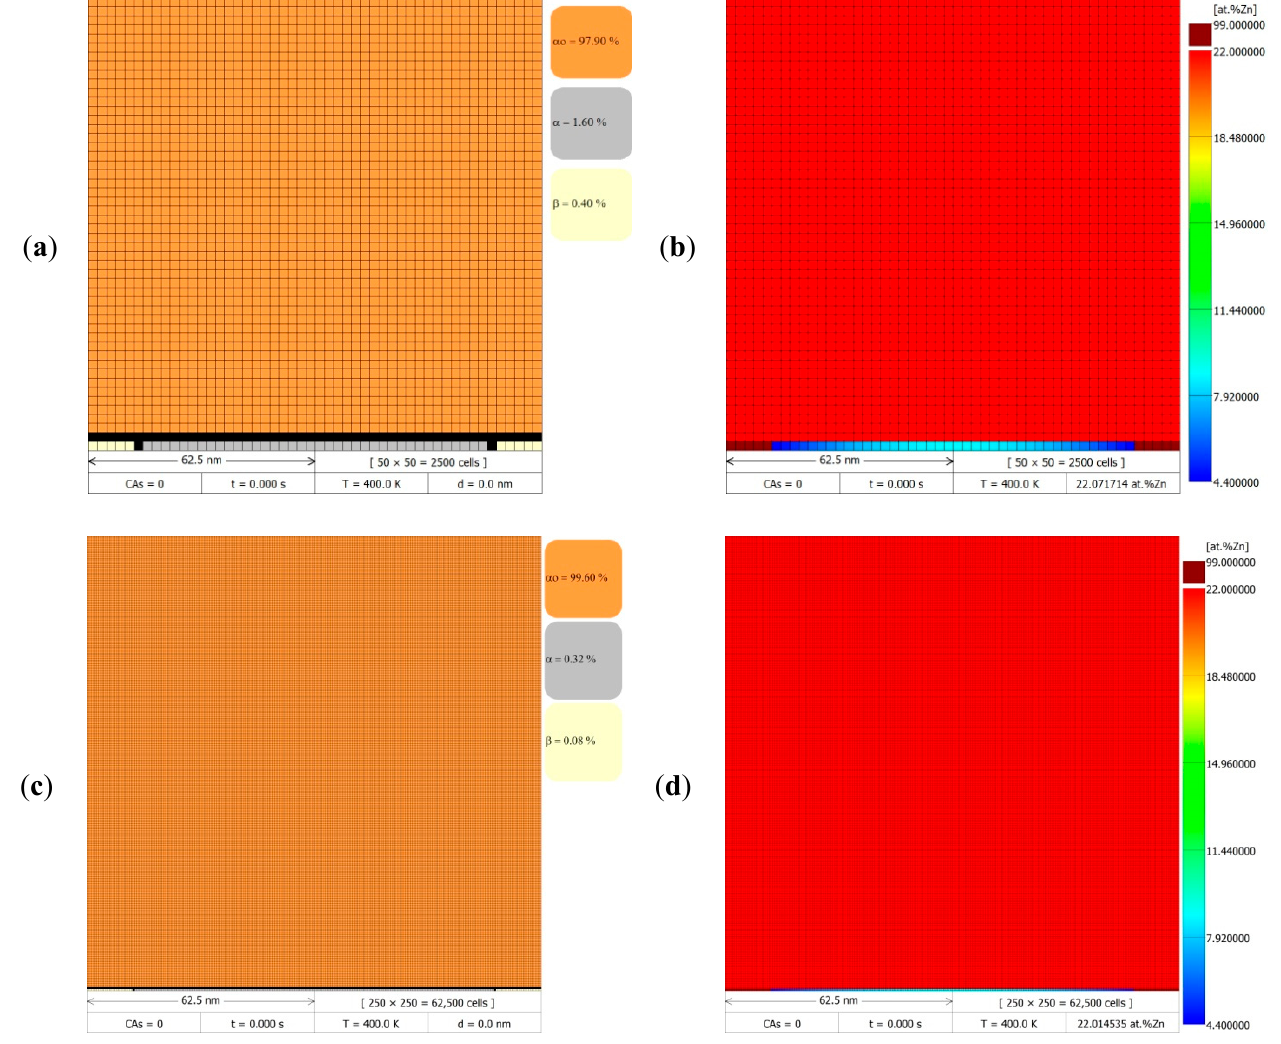
Figure 5. Initial conditions in the digital material representation of the microstructure fragment (125 × 125 nm 2 ), for two cases of discretisation with a CA grid of size: ( a , b ) 50 × 50 = 2500 cells, and ( c , d ) 250 × 250 = 62,500 cells, where left column presents the current phases and right column depicts maps with zinc redistribution.